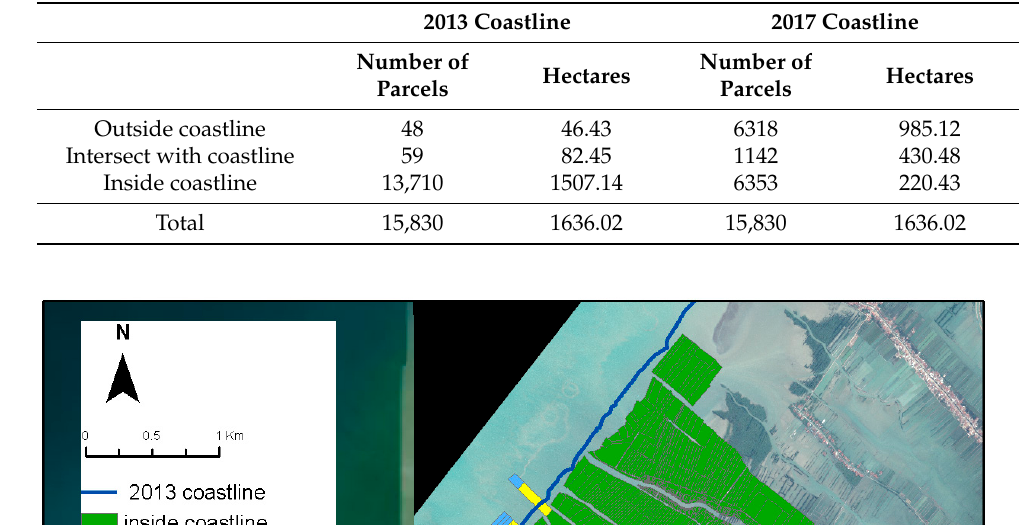
Table 1. The number of land parcels and the area (in hectares) that located outside, intersect with, and inside the coastline in 2013 and 2017. Land parcel data sourced from the taxation map issued by Local Government of Kabupaten Demak, while the coastline data were obtained from the Ministry of Marine and Fisheries.